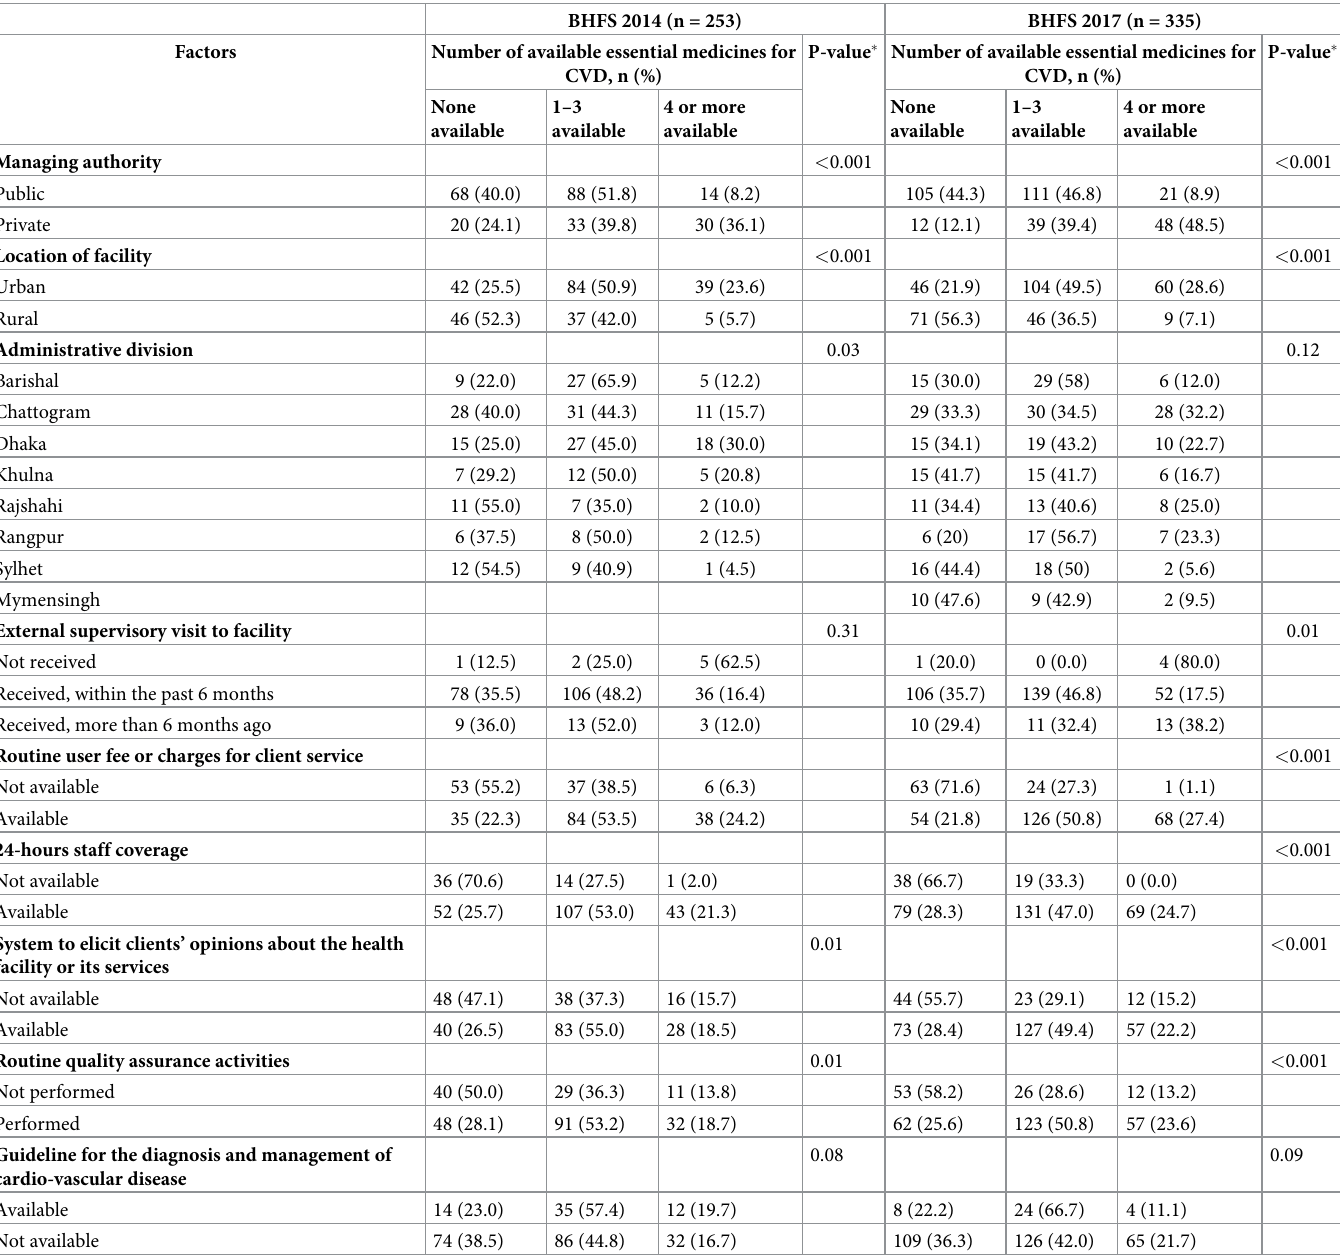
Table 1. Distribution of different factors by the number of available essential medicines for CVD, Bangladesh Health Facility Survey (BHFS), 2014 and 2017. BHFS 2014 (n = 253) BHFS 2017 (n = 335) Factors Number of available essential medicines for CVD, n